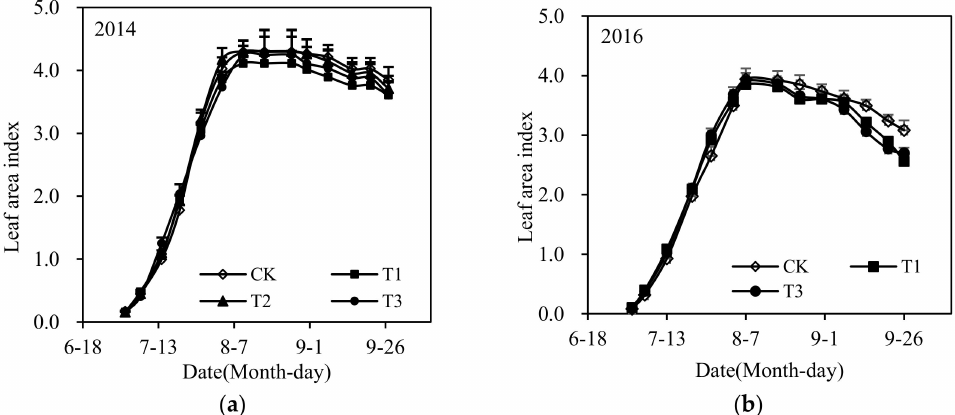
Figure 5. Leaf area index during the warming growth duration in 2014 ( a ) and 2016 ( b ). CK, T1, T2, and T3 denote the control, nocturnal warming during the whole growth season, and nocturnal warming during the vegetative and reproductive stages, respectively.